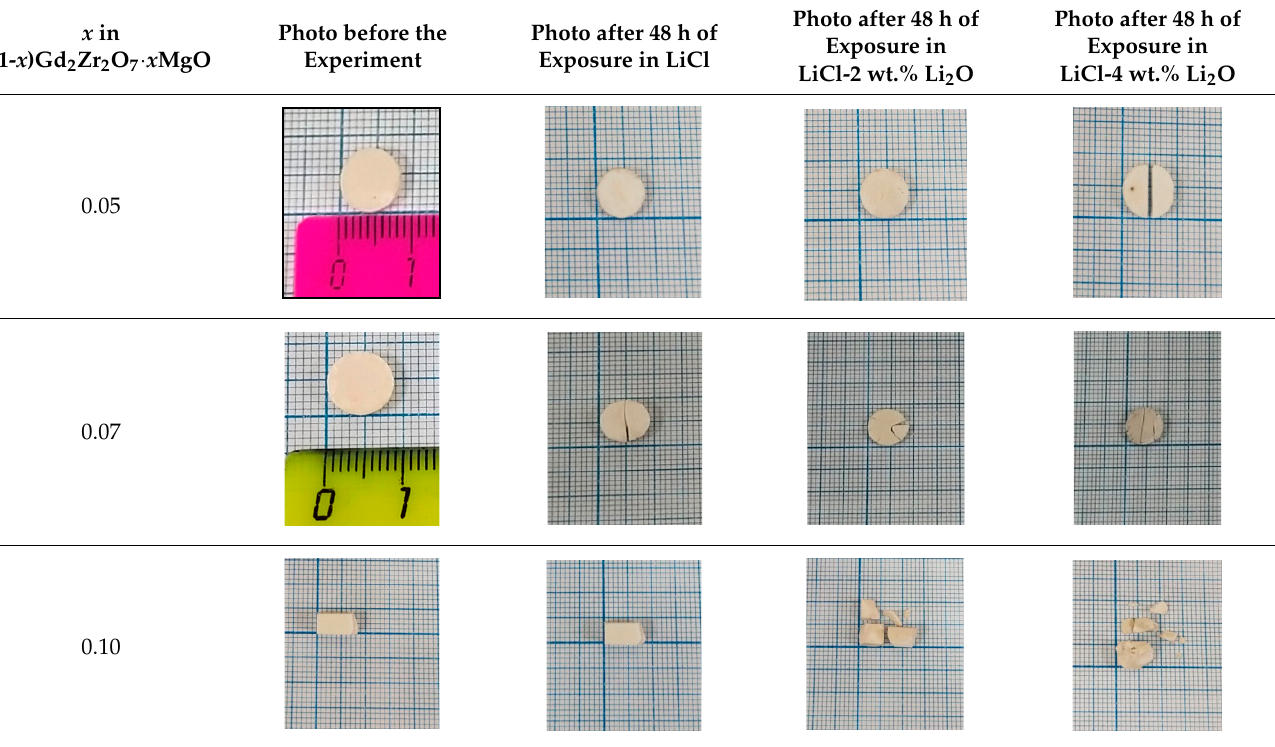
Table 5. Change in the mass loss of ceramic samples of (1- x )Gd 2 Zr 2 O 7 · x MgO before and after expo- sure in LiCl- x Li 2 O melts at T = 650 °C.